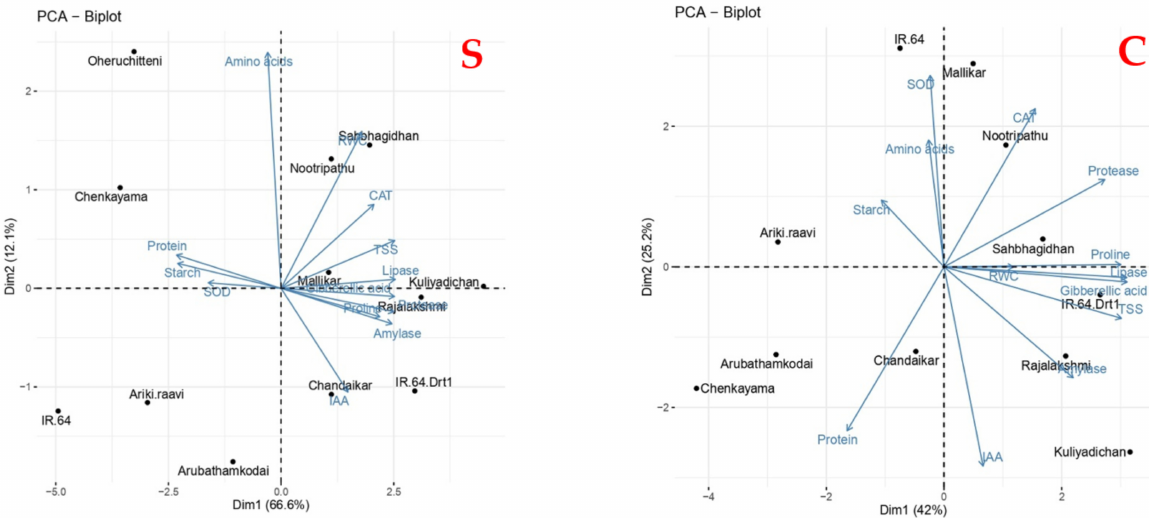
Figure 7. Biplots of principal component analysis under osmotic stress ( − 1.5 Mpa) for morpho- physiological, biochemical and metabolic responses in rice genotypes: S—induced moisture stress of − 1.5 MPa in comparison to IR 64 Drt1; C—controlled